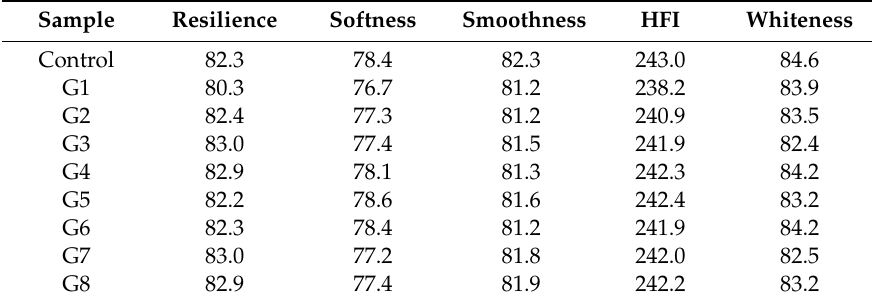
Table 6. Hand feel properties of fabric samples coated with di ff erent antibacterial recipes. Sample